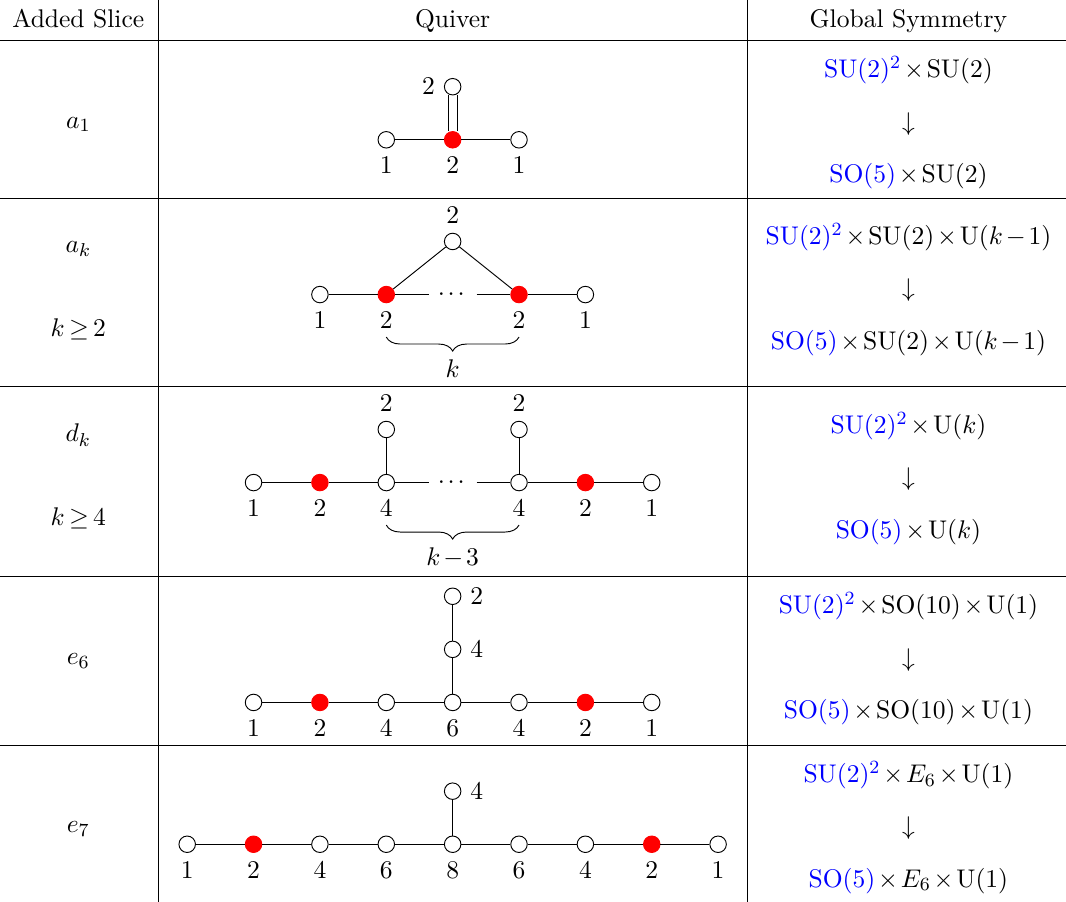
Table 7 . Quivers resulting from adding all possible elementary slices to n.min B 2 (4.7) to absorb a